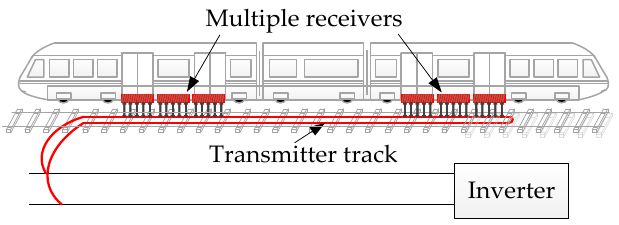
Figure 1. Transmitter track and multiple receivers in the wireless power supply system for railway applications.